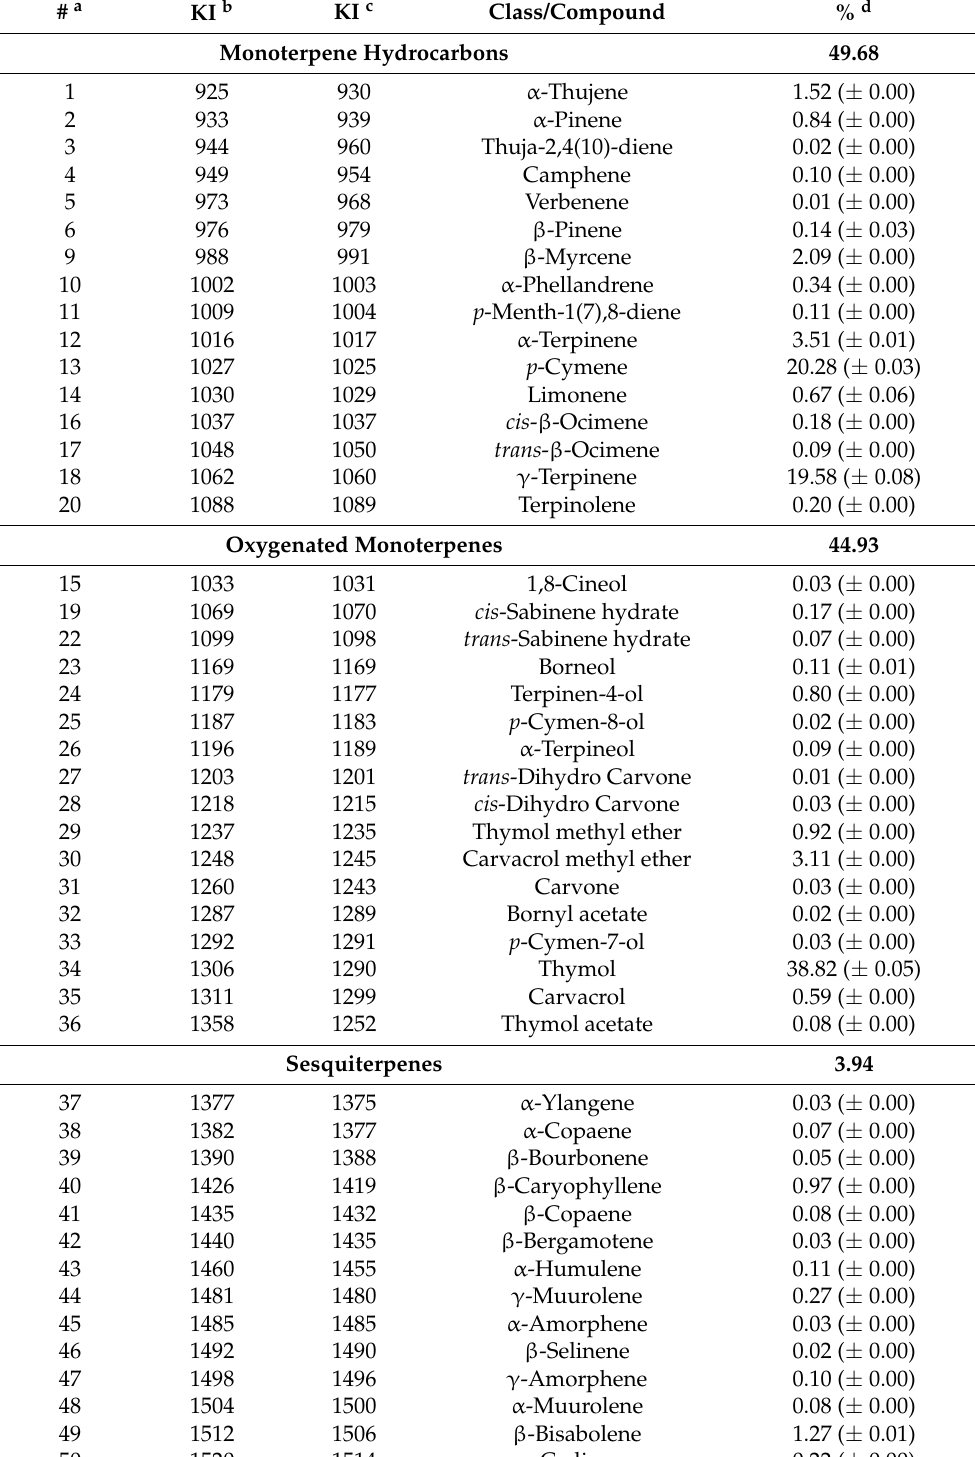
Table 1. Chemical composition of commercial Origanum vulgare ssp. hirtum essential